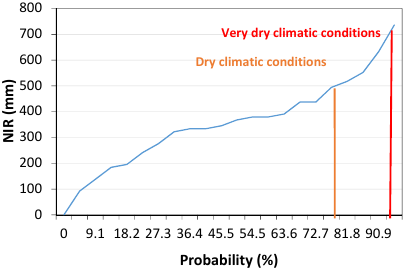
Figure 5. Net irrigation requirements for maize in Paysandú with identification of the dry and very dry climatic demand conditions.